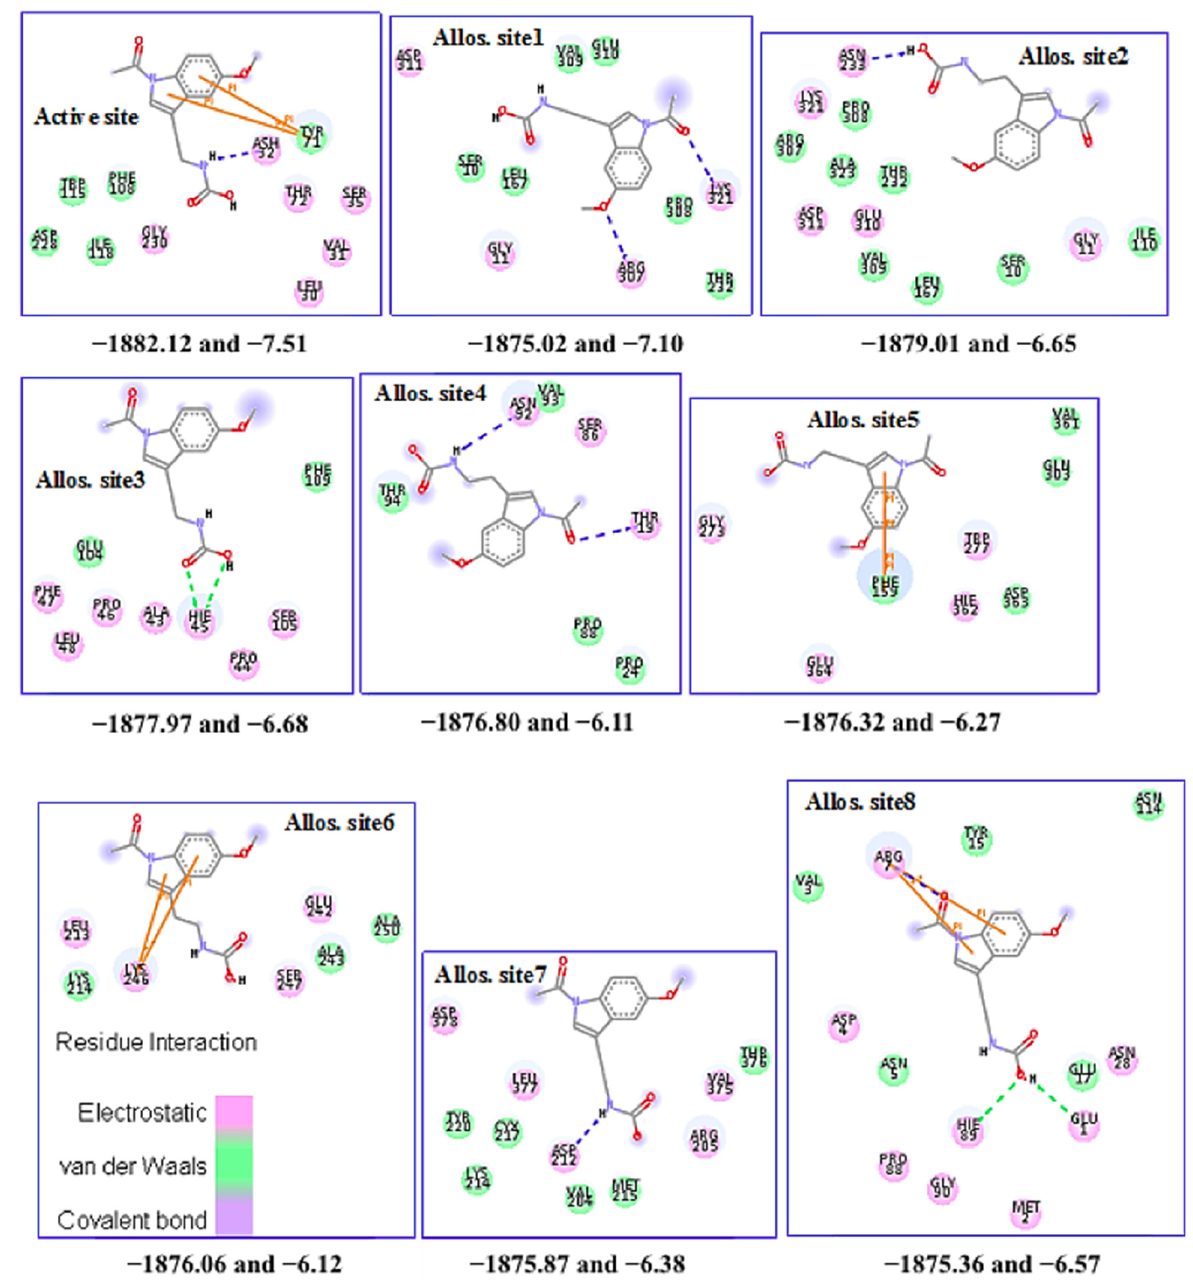
Figure 6. The interaction profile of compound 1 for its various poses on the BACE1 scaffold. The first and second values below each pose are full fitness and binding energy in kcal/mol, respectively. Allos. site signifies allosteric site, the dashed green and blue lines represent classical hydrogen bond and bridging water HB, respectively. Table 1. Full fitness and binding energy (in kcal/mol) predicted from docking of potent allostery the catalytic active site of BACE1 as proposed [42] and validates the accuracy of the docking method.